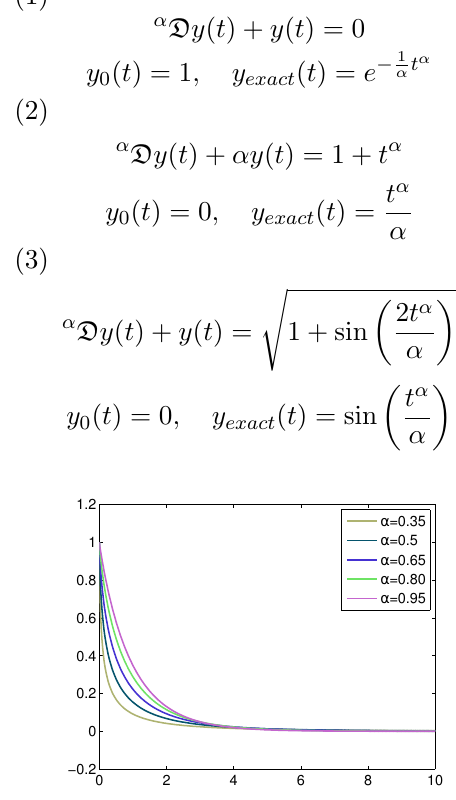
Figure 1. y ( t ) versus t using multi- quadric basis function with ε = 10 − 4 for p ( t ) = 1 and q ( t ) = 0 for different value of α .